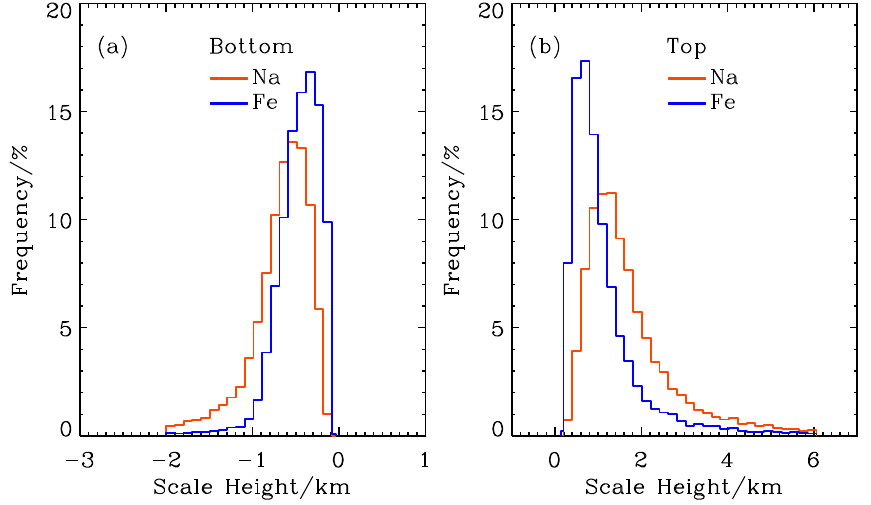
Fig. 4. Distribution of Na and Fe number density scale heights for the layer bottom (ten consecutive points lowest in altitude) and top (ten consecutive points highest in altitude) from the 1073 pairs of the 15-min Na and Fe density profiles measured simultaneously on 47 different nights at 30 ◦ N.